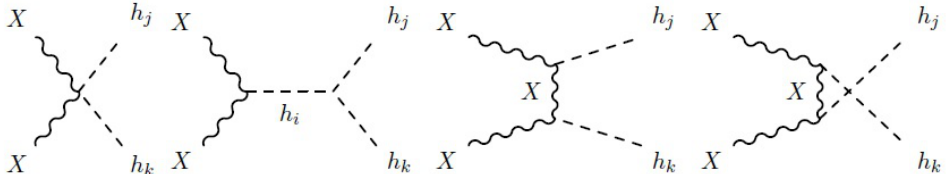
Figure 13 . Feynman diagrams for DM annihilation to SM gauge bosons and fermions, with h i = { H, S } .